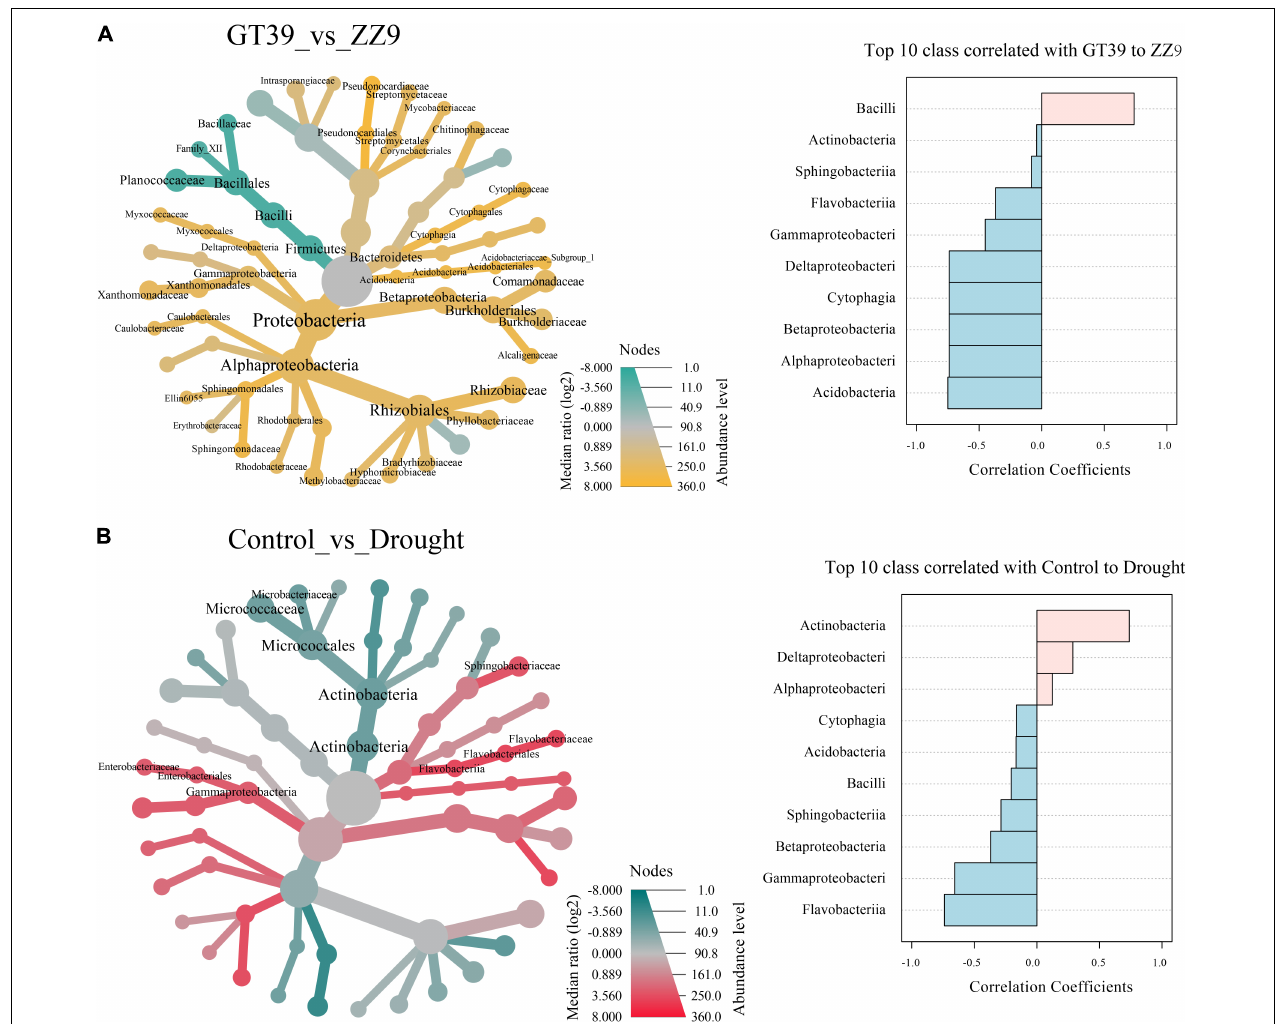
FIGURE 4 | Visualization of classification differences in tree heat maps. (A) The influence of the differences between the GT39 and ZZ9 varieties on the rhizosphere flora. EdgeR represents the top ten major flora with a greater correlation with the drought tolerance of the two varieties, and pink and blue indicate the drought resistance of the variety. Relevance. (B) Control the differential effects of watering and drought stress on the rhizobacteria, edgeR represents the top ten major flora associated with water stress, pink and blue represent the correlation with the degree of water